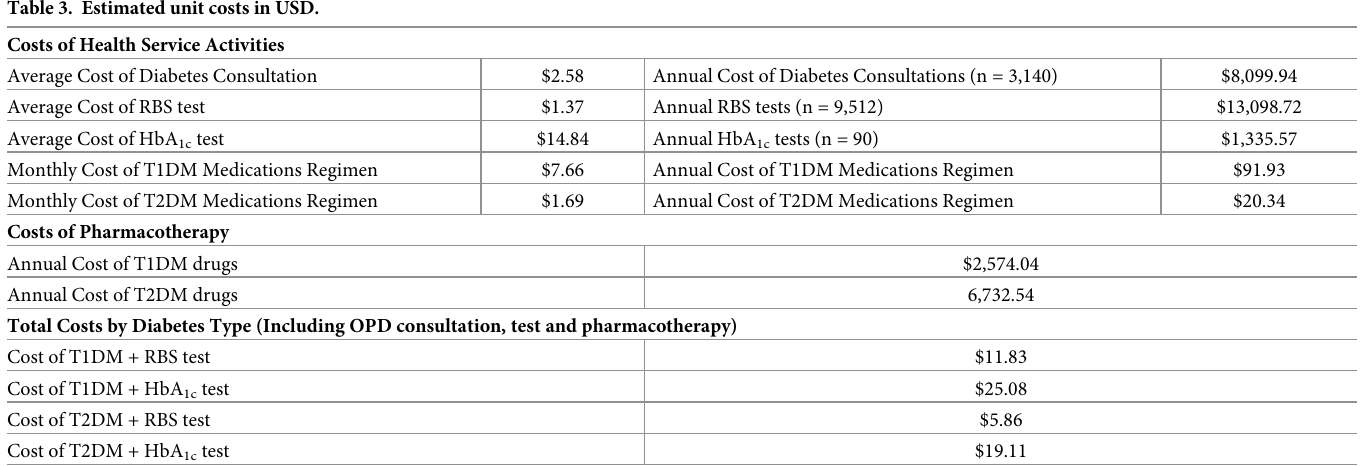
Table 3. Estimated unit costs in